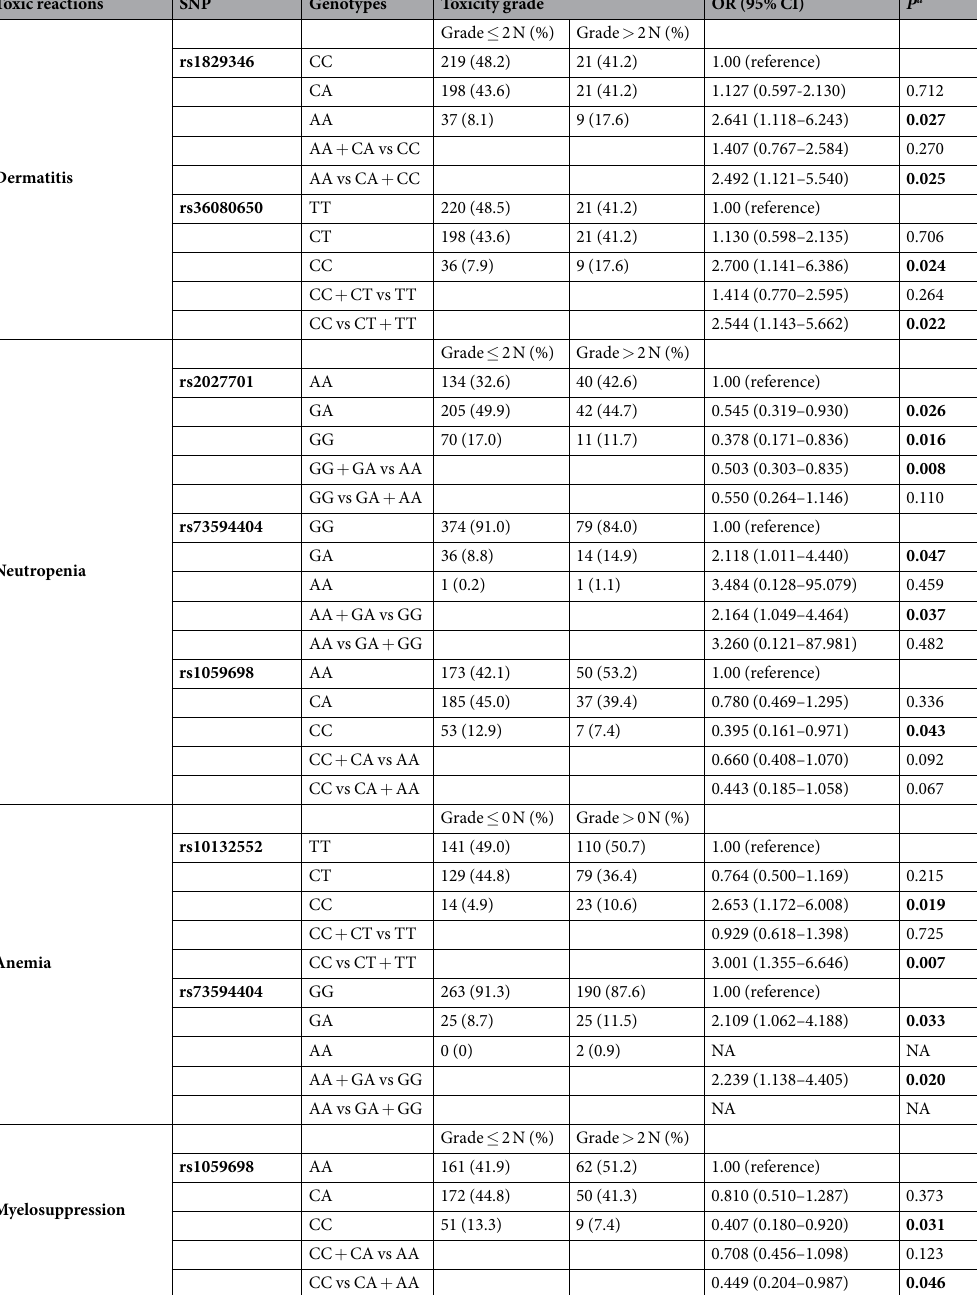
Table 3. Associations between genotypes and concurrent chemoradiotherapy-induced toxicities Abbreviations: CI, confidence interval; OR, odds ratio. P a values were calculated with adjustment for age, sex, BMI, smoking status, drinking status, histological type, clinical stage, T-staging, N-staging, Induction chemotherapy regimens, concurrent chemoradiotherapy regimen, irradiation dose. P value < 0.05 is shown in